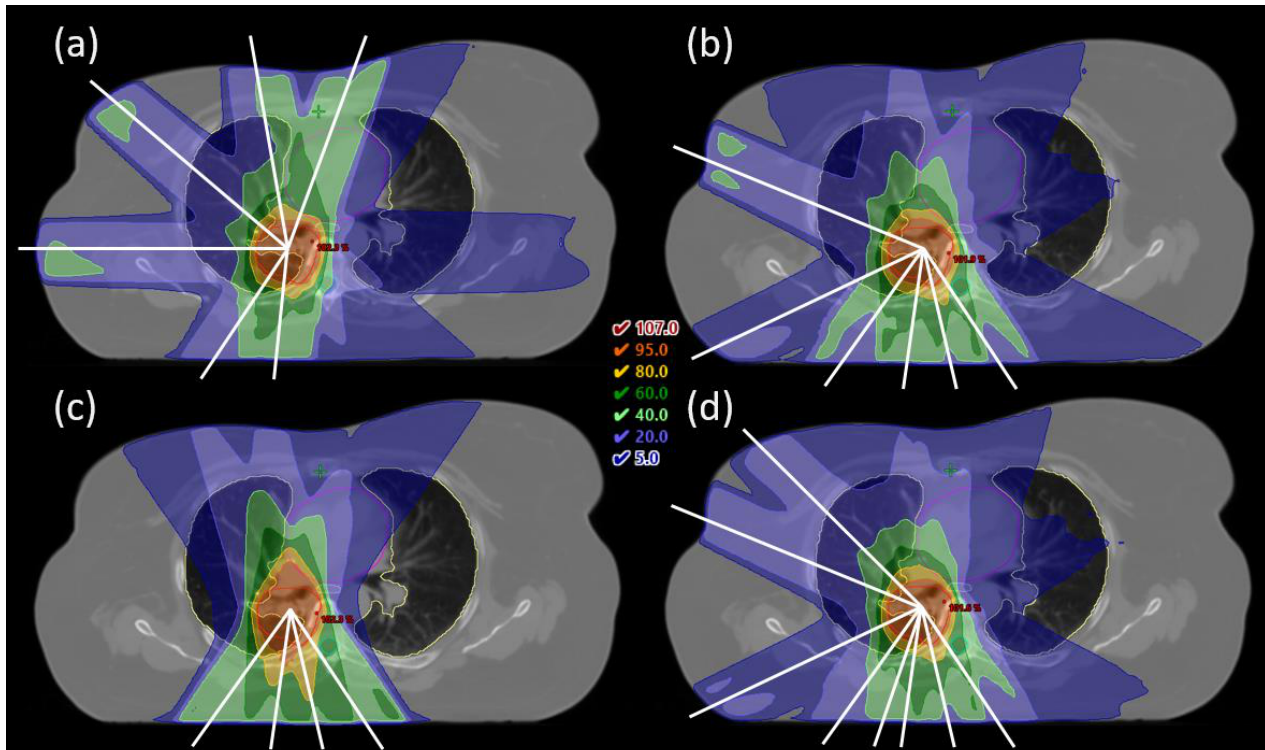
Figure 4. ( a ) CLIN plan with manually selected beam angles for patient 1. ( b – d ) iCE plans with 6, 4 and 8 optimized beam angles for the same patient. Dose is shown relative to the prescribed dose (66 Gy). Contours are the PTV (red), lungs (yellow), heart (magenta), esophagus (grey) and spinal cord (cyan), and beam angles are indicated by white lines.